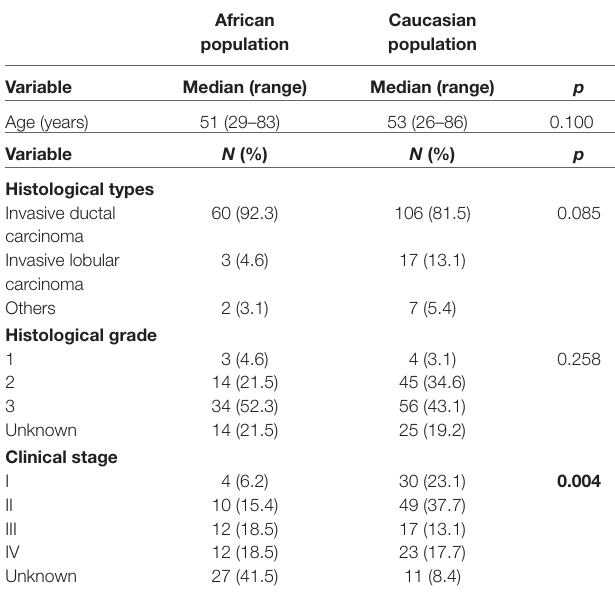
TaBle 1 | Clinical and pathological features of the African and Caucasian population.